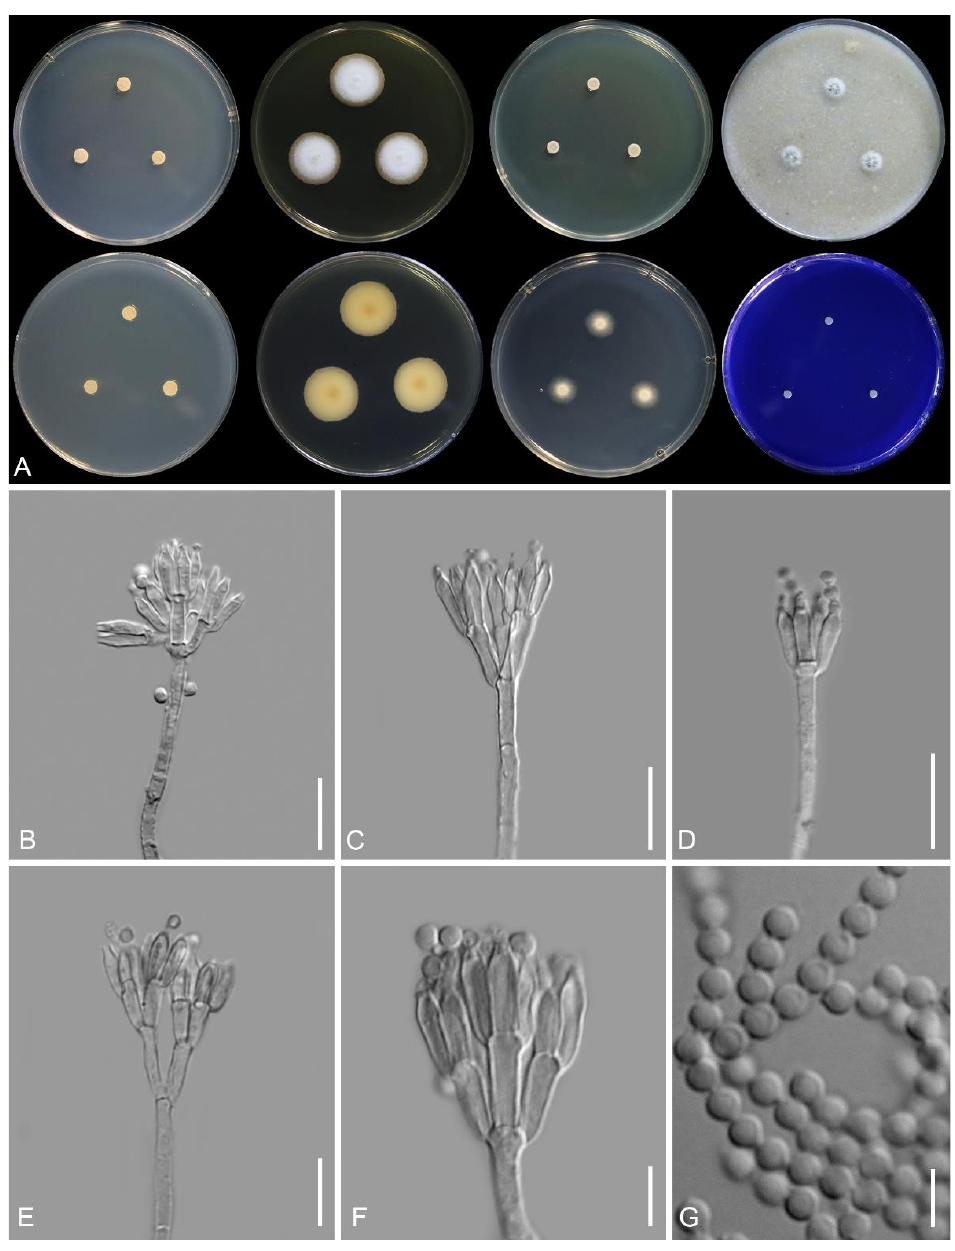
Figure 5. Talaromyces satunensis TBRC 16246. ( A ) Colonies from left to right: (top row) CYA, MEA, YES, and OA, and (bottom row) CYA reverse, MEA reverse, DG18, and CREA. ( B – F ) Conidiophores. ( G ) Conidia. Scale bars: ( B – F ) = 10 µm, G = 5 µm. MycoBank: